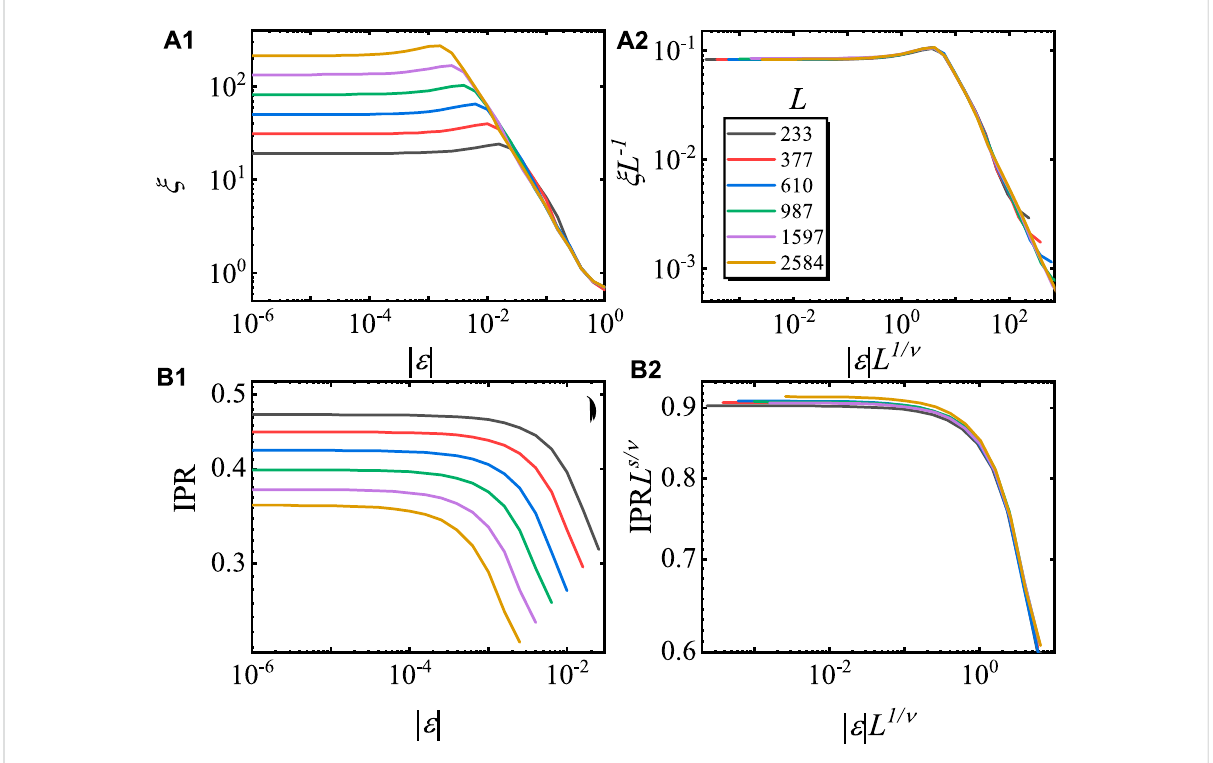
FIGURE 4 Finite scaling of ξ and IPR of the ground state in the skin effect phase. The curves of ξ versus | ε | before (A1) and after (A2) rescaling, according to Eq.5fordifferent L values.ThecurvesoftheIPRversus| ε |before(B1)andafter(B2)rescaling,accordingtoEq.8fordifferent L values.Here, g =0.5, ε < 0, and the model is in the skin effect phase region. Double-log scales are used, and the results are averaged for 100 choices of ϕ